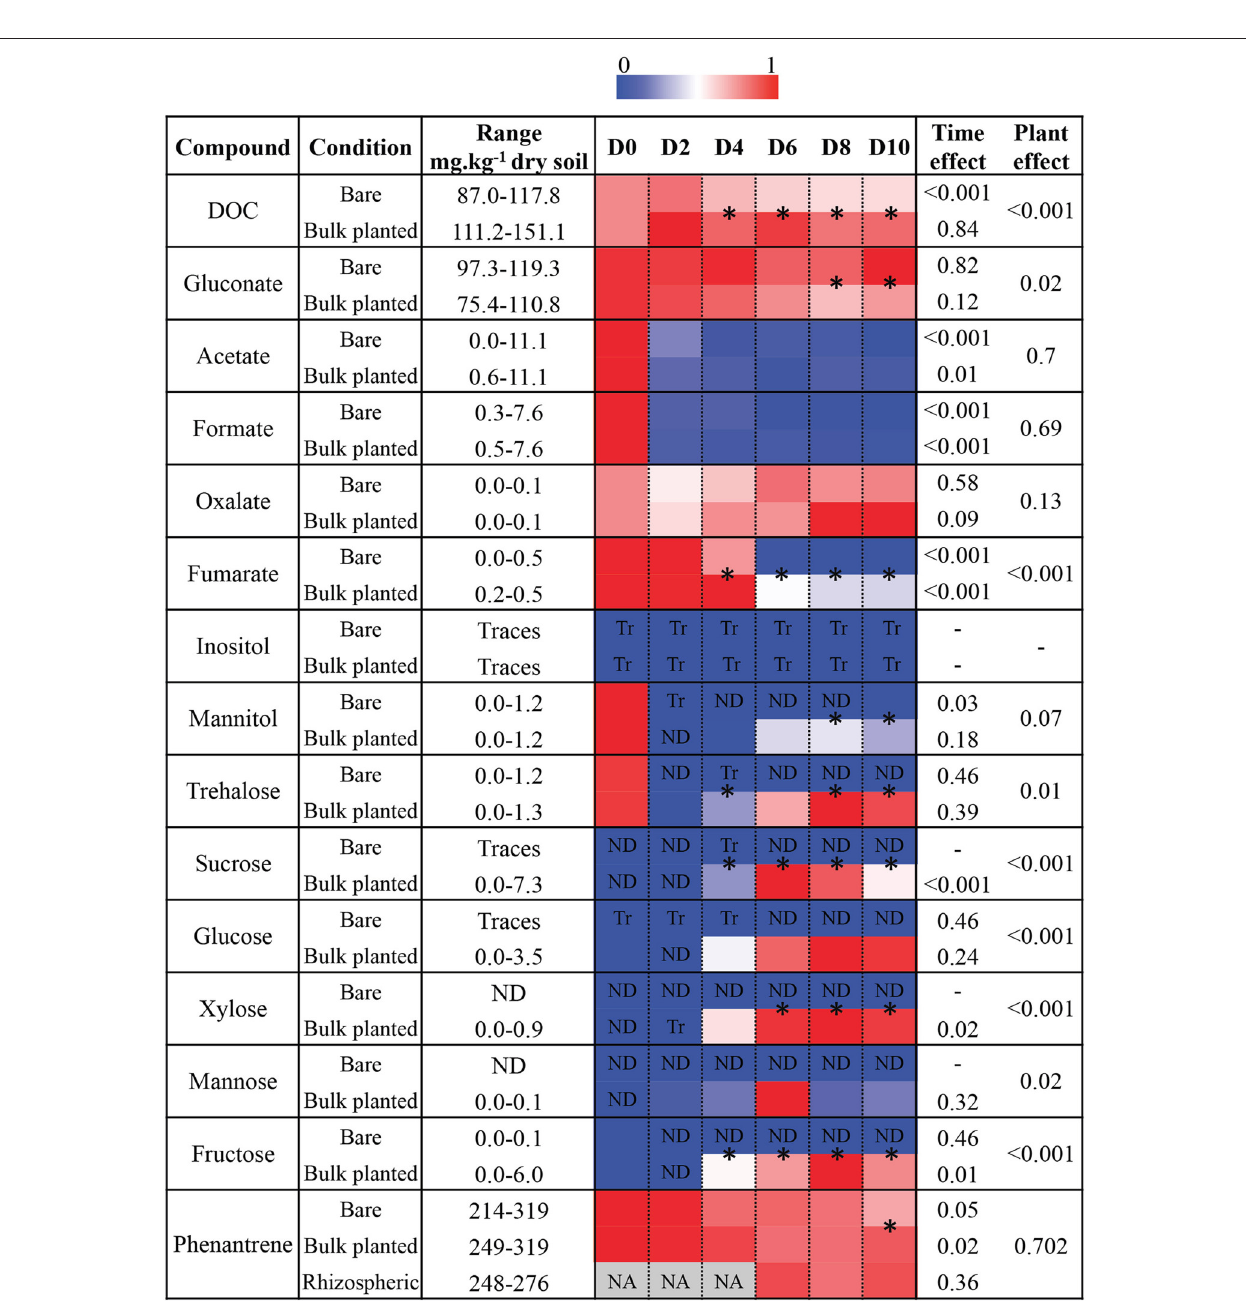
FIGURE 2 | Changes in total dissolved organic carbon (DOC), organic acids, sugars, and phenanthrene concentration in soil extracts over time, in bare and bulk planted soils from day 0 (D0) to day 10 (D10). For each compound, maximum detected concentrations were set to 1 and measurements were scaled accordingly. Values are means of three independent replicate microcosms. P -values obtained from one-way ANOVAs testing for the overall effect of vegetation and the effect of time for each condition are given. Asterisks between two adjacent cells denote significantly different values between bare and bulk planted soil ( t -test, P < 0.05